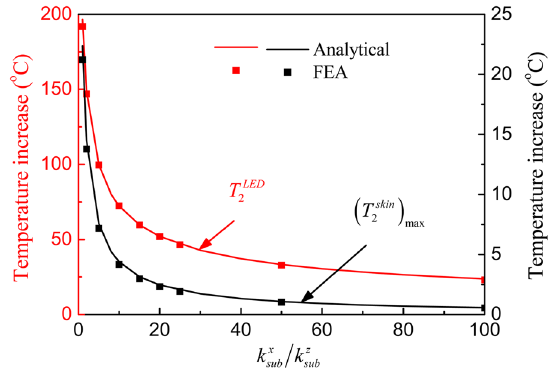
Figure 3. Effects of the orthotropic substrate on the μ -ILED temperature increase and the maximum skin temperature increase under a constant power of 10 mW.